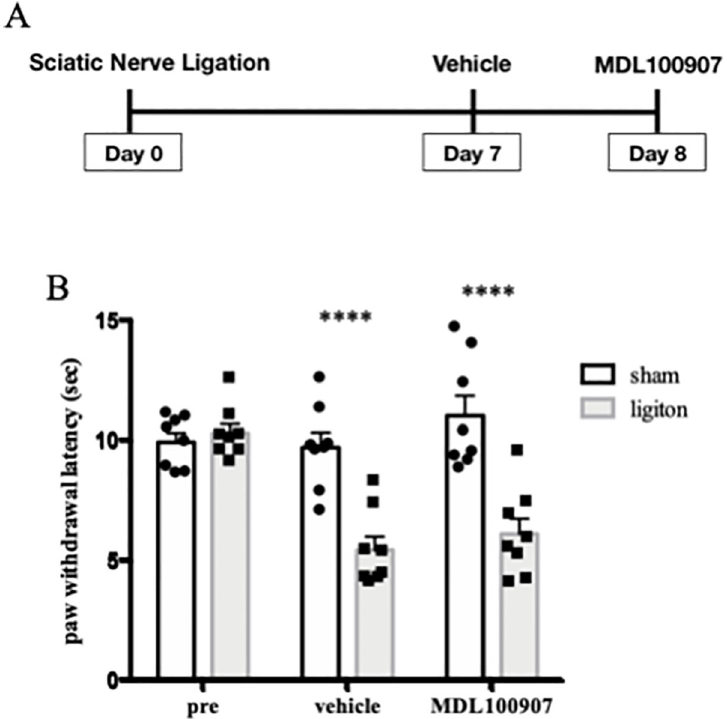
Fig 5. Selective 5HT 2A receptor antagonist improved thermal hyperalgesia in neuropathic pain model. Plantar tests were performed before nerve ligation surgery, on test day 7 with vehicle, and on test day 8 with MDL 100907 administration (n = 8) (A). Paw withdrawal latencies were plotted for every test. Data are expressed as means ± SEM. Data are analyzed using two-way ANOVA followed by Bonferroni’s post hoc test and considered statistically significant at ���� P < 0.0001 when comparing the sham and ligation groups